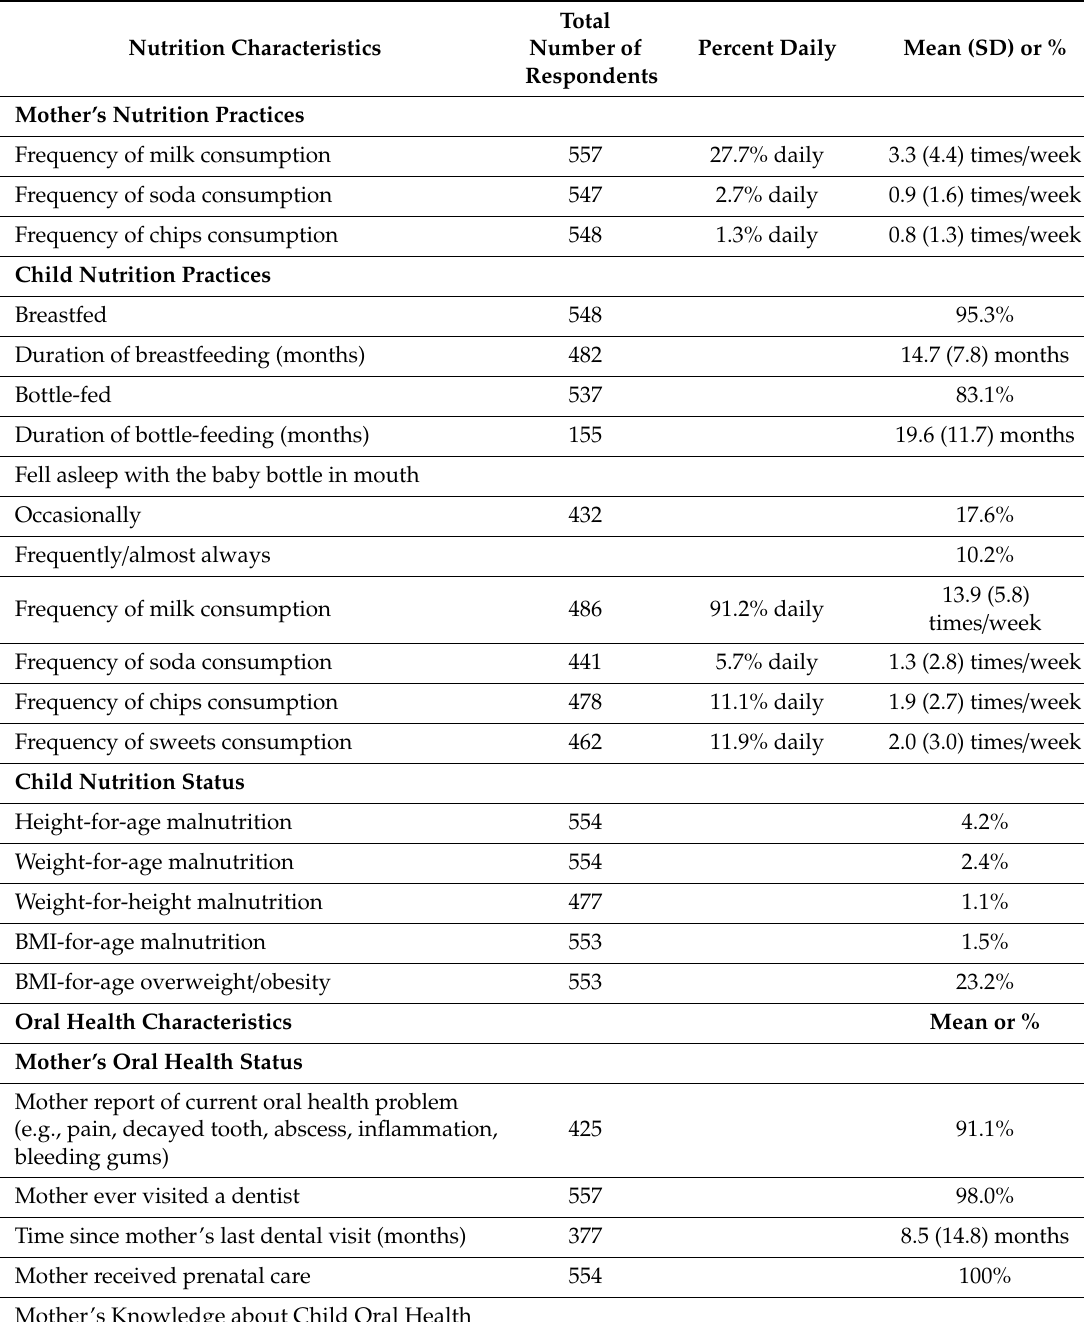
Table 2. Maternal and child nutrition and oral health